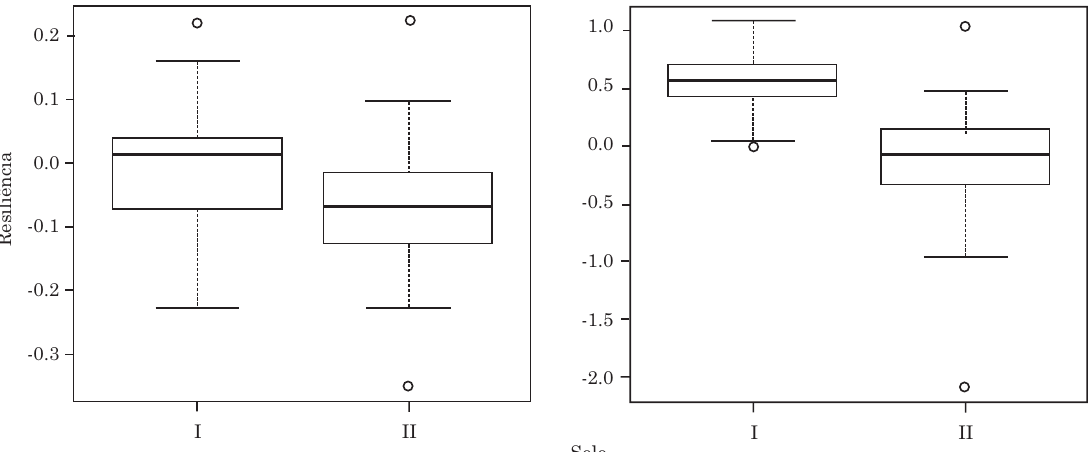
Figura 7. Distribuição dos índices de resiliência da porosidade total e de aeração dois Latossolos Vermelhos distróficos, um argiloso (I) e um franco-argilo-arenoso (II). As barras representam o intervalo de confiança da média (85